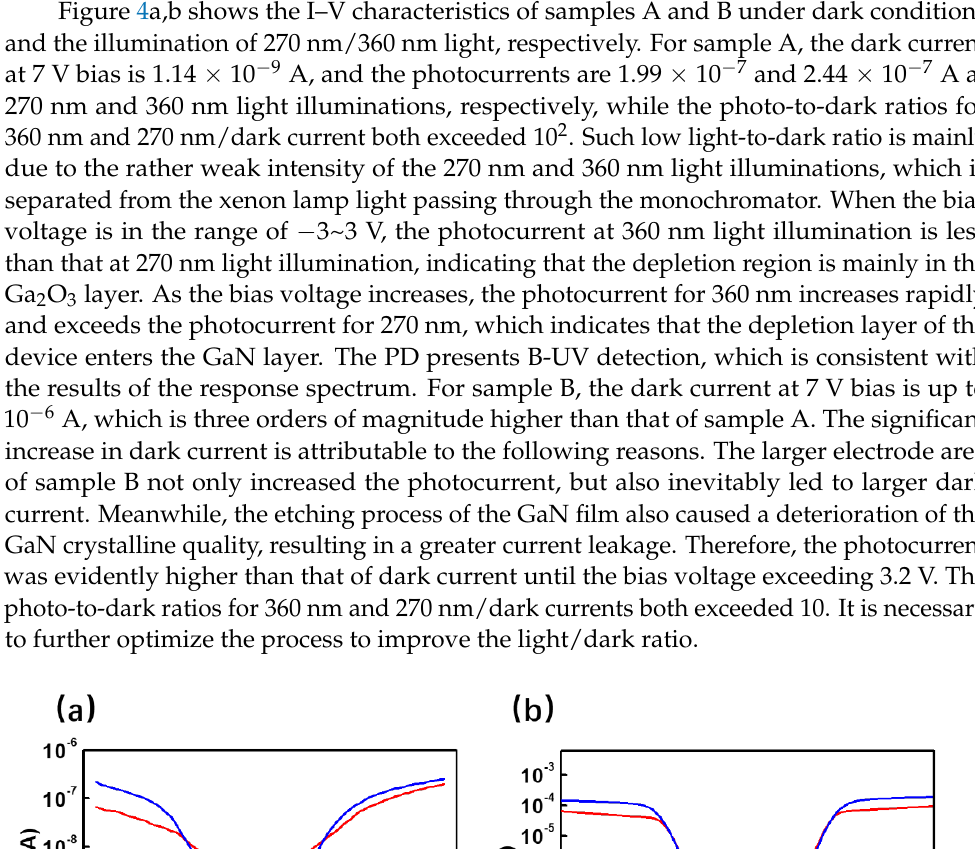
Figure 5. ( a , b ) Schematic of reaction of Ga 2 O 3 /GaN core-shell micron rod with oxygen and band of Ga 2 O 3 films after reaction with oxygen respectively ( c ) Schematic of holes transferred to the surface of Ga 2 O 3 film under UV-C illumination; ( d ) Schematic of photo-generated holes in GaN layer gath- ering at Ga 2 O 3 /GaN heterojunction interface owing to capacitance effect under UV-A illumination. Moreover, the Ga 2 O 3 /GaN core-shell MRAs with higher surface-to-volume ratios ef- fectively improved the light absorption efficiency and thus excited more photogenerated carriers. Because of the larger electrode area, these additional photogenerated electrons can be effectively collected and increase the photocurrent. In addition, more holes were blocked at the Ga 2 O 3 /GaN interface underneath the electrode, resulting in high responsiv- ity. Since the Ga 2 O 3 /GaN heterojunction has the low conduction band barrier (0.1 eV) and high valence band barrier (1.4 eV), the photogenerated electrons in the GaN layer can pass through the Ga 2 O 3 /GaN heterojunction and be collected by the electrode. Meanwhile, the photogenerated holes in GaN are effectively blocked in the Ga 2 O 3 /GaN heterojunction, noting that these blocked photogenerated holes are mainly located at the Ga 2 O 3 /GaN het- erojunction interface below the electrode. A larger metal electrode area can block more holes, thus leading to greater photoconductance gain. The designed structure effectively